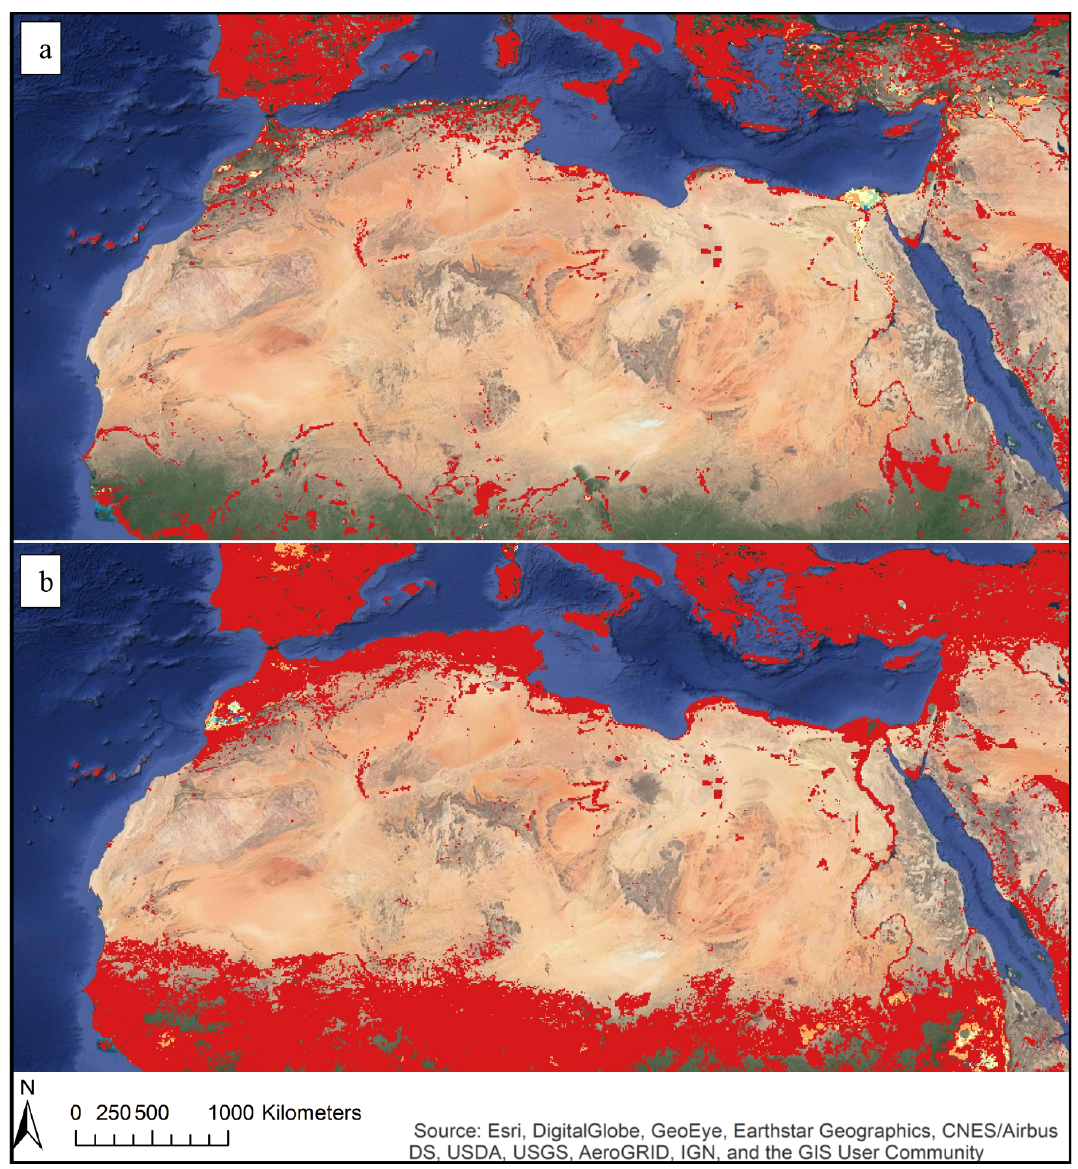
Figure 2. Aggregated maps for all 42 crops produced using Harvest Choice data [25]: ( a ) total area irrigated; and ( b ) rainfed. Areas in red show the presence of the cultivation of at least one crop at the lower end of the scale. Areas not shaded indicate that no data are available. Zeroes (cells where there are available data but no cultivation) have been removed (maps elaborated with